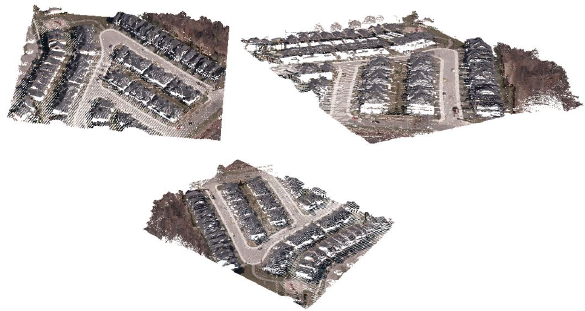
Figure 12. Registered LiDAR points - RGB